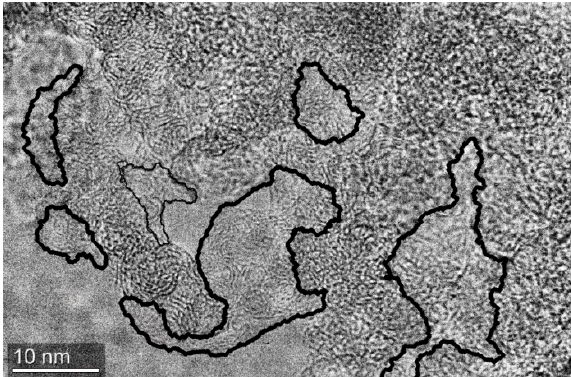
Figure 3. The porous microstructure of RF-1000 ( A ), RF-1100 ( B ) and RF-800 aerogels ( C ).